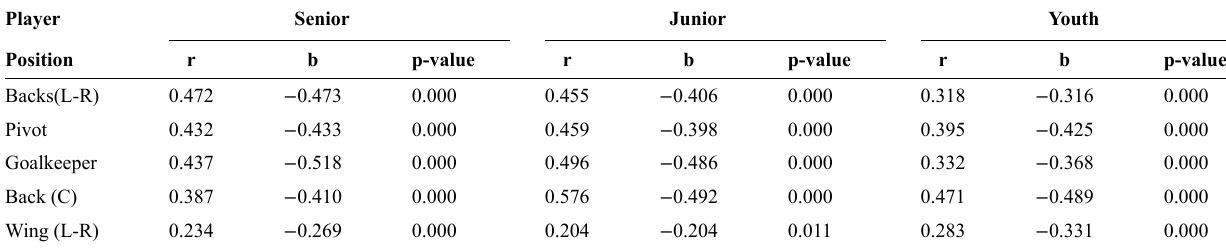
Table 5 - Regression analysis of the dependence of ranking on player height for each category and player position. Shown are the correlation coefficients, the beta coefficients of the regression equations and their corresponding p-values.